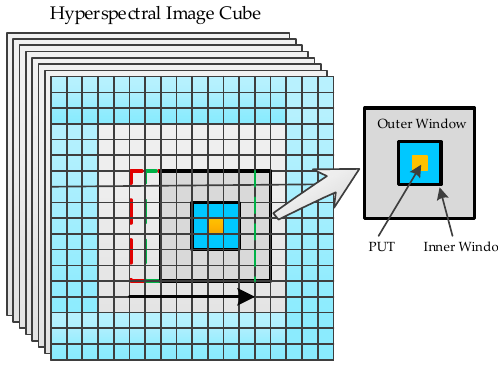
Figure 4. Dual concentric windows model for WSSKRX anomaly detection.